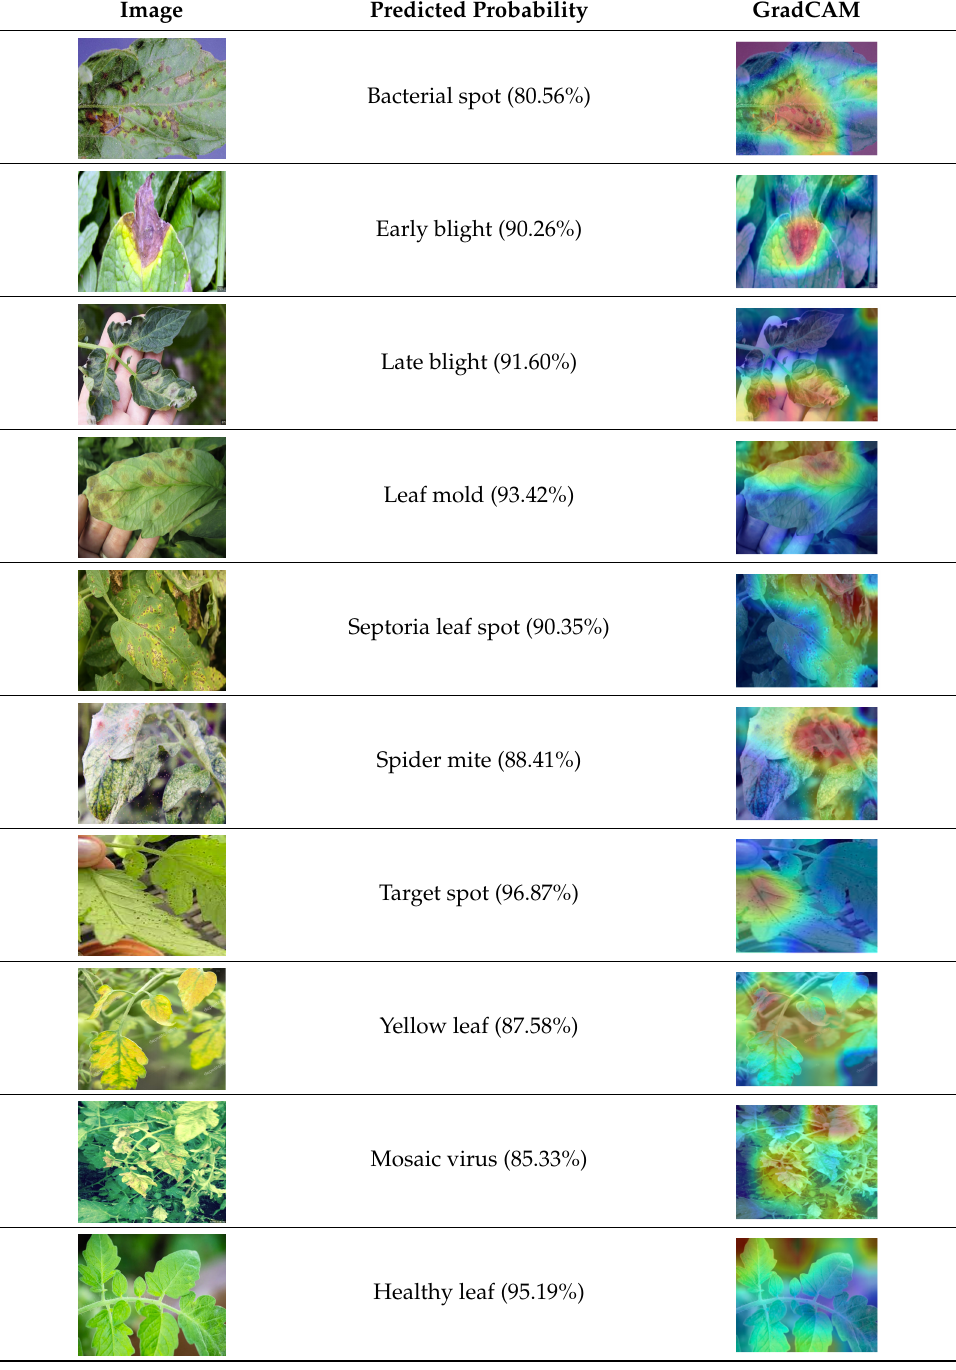
Table 7. Real-time